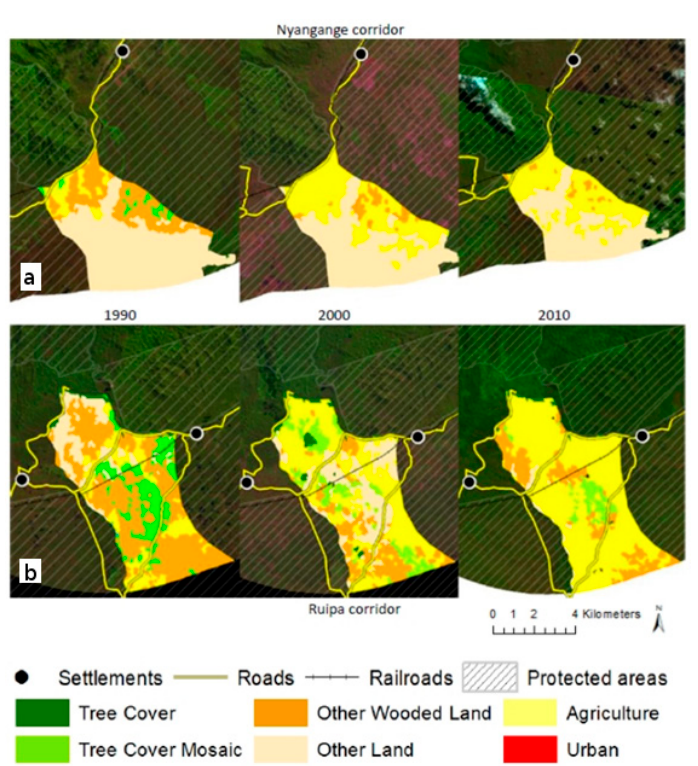
Figure 6. Land use/cover (LULC) evolution in the Nyangange ( a ) and Ruipa ( b ) corridors.